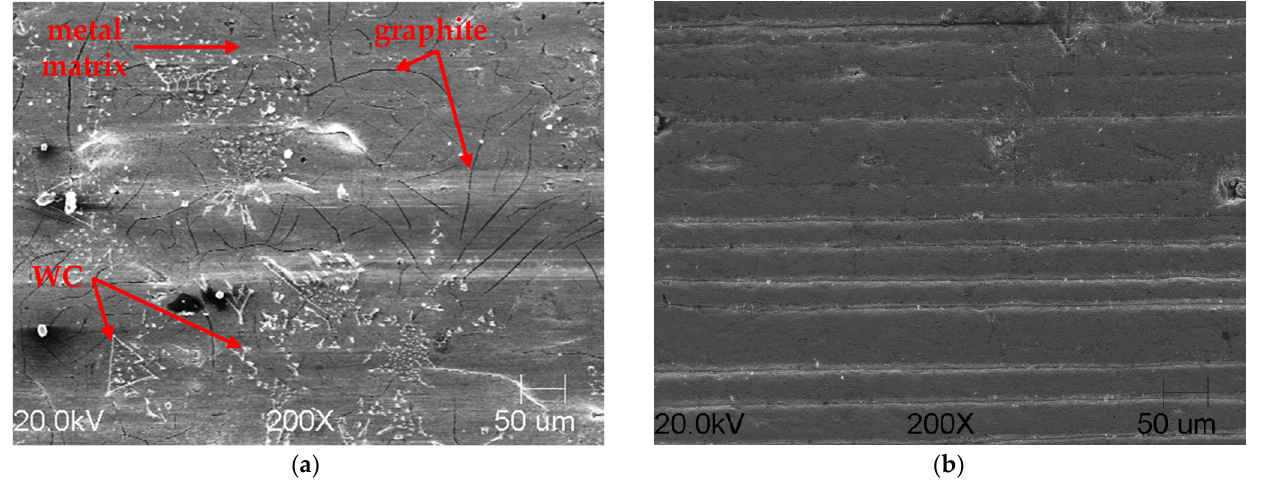
Figure 12. SEM images of high-aluminum cast iron with the addition of tungsten ( a ) and SEM images of high-chromium cast iron ( b ) after a full abrasion test with the Miller machine.